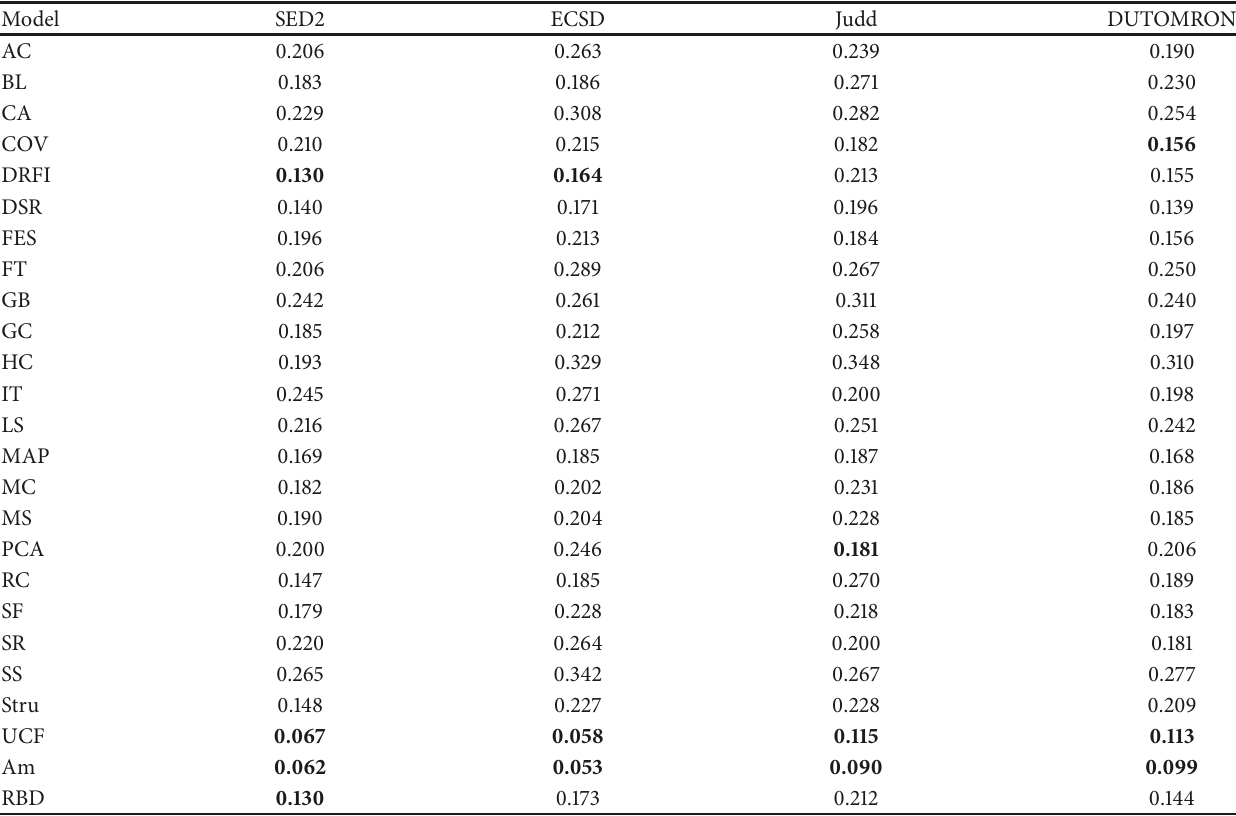
Table 2: MAE score (smaller is better; the top three models are highlighted in